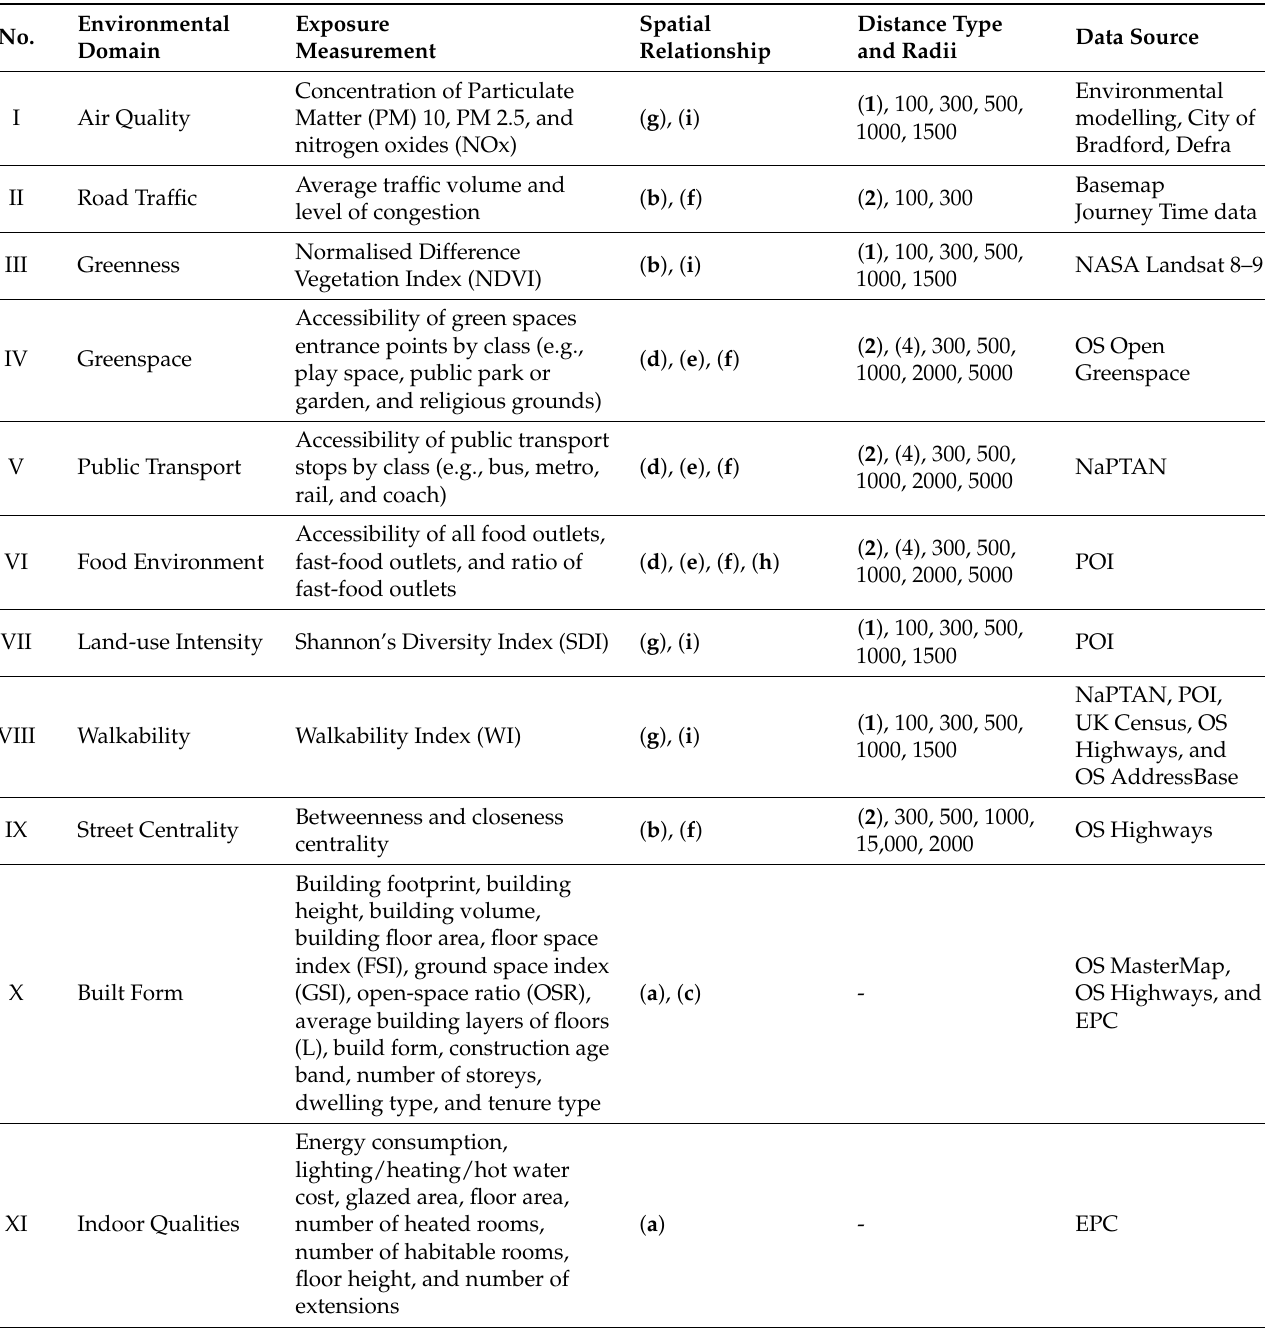
Table 1. Overview of environmental indicators, exposure measurements and data